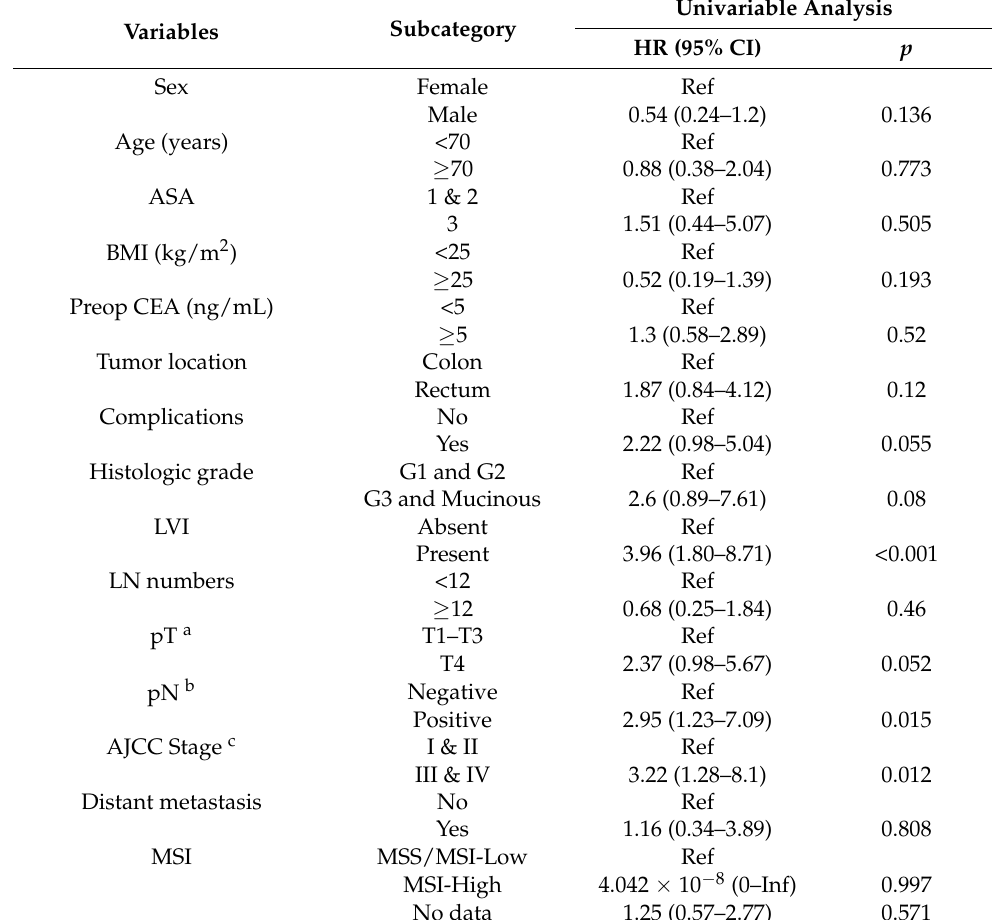
Figure 1. The Kaplan–Meier plot in the training and the validation set according to the high-risk and low-risk groups. Kaplan–Meier survival analyses according to the rad_score for patients in the training ( A ) and the validation ( B ) sets. The Kaplan–Meier curve showed that the radiomics signature was significantly associated with progression-free survival (PFS) in the training set ( p < 0.001) and in the validation set ( p = 0.008). Table 3. Univariable analysis associated with the progression-free survival in the training